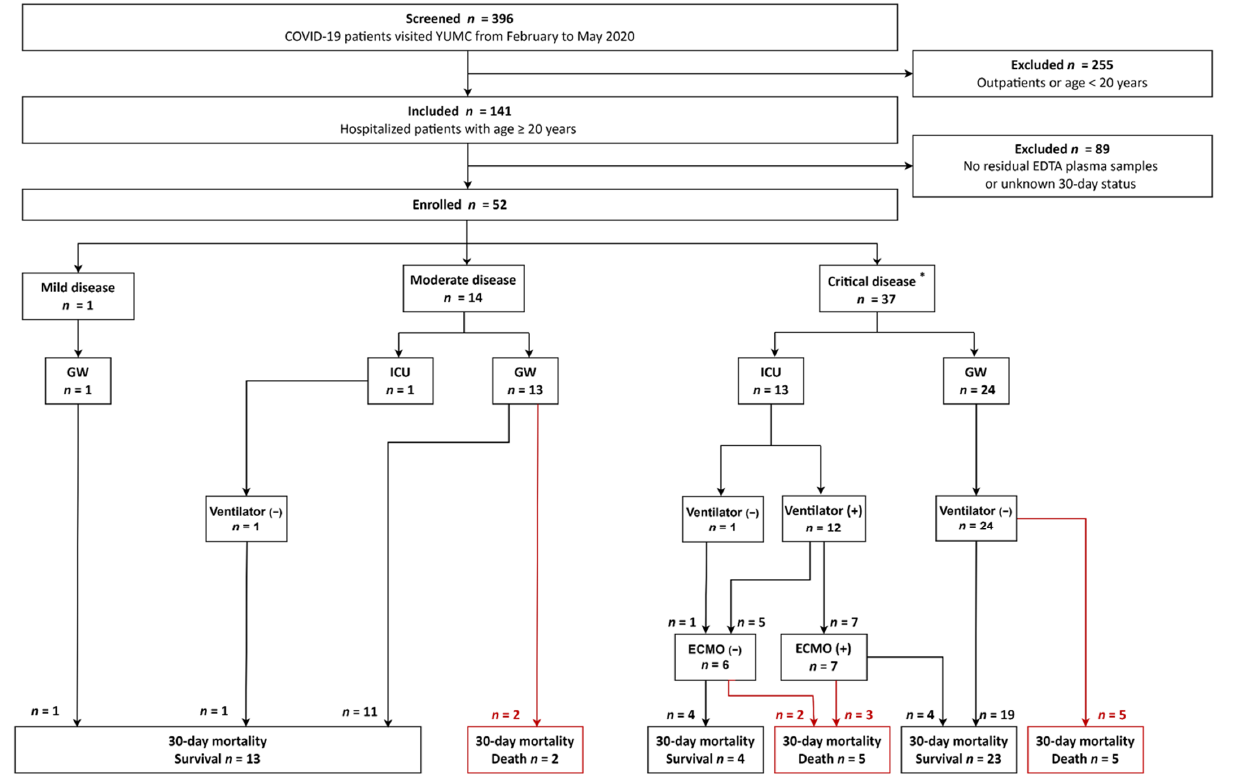
Figure 1. The enrollment and clinical outcomes of the study population. None of the study population presented severe disease in terms of WHO disease severity. The red line indicates death with regard to 30-day mortality. * Among 37 patients with critical disease, 31 patients had sepsis and six patients had septic shock. Abbreviations: WHO, World Health Organization; COVID-19, coronavirus disease 2019; YUMC, Yeoungnam University Medical Center; EDTA, ethylene-diamine-tetraacetic acid; ICU, intensive care unit; GW, general ward; ECMO, extracorporeal membrane oxygenation.